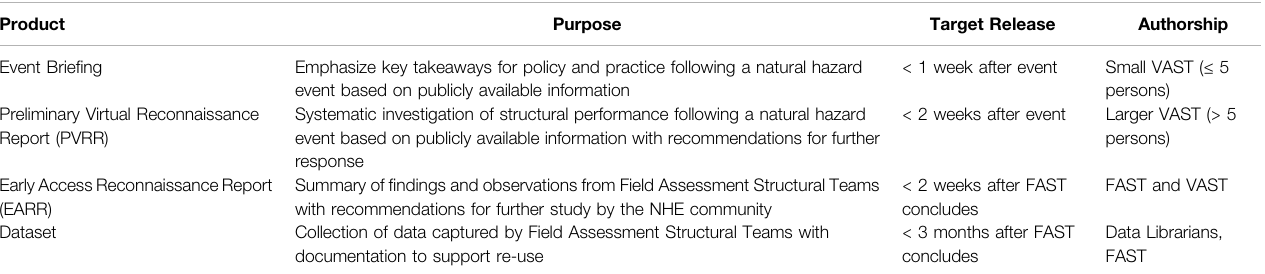
TABLE 4 | Overview of primary StEER event response